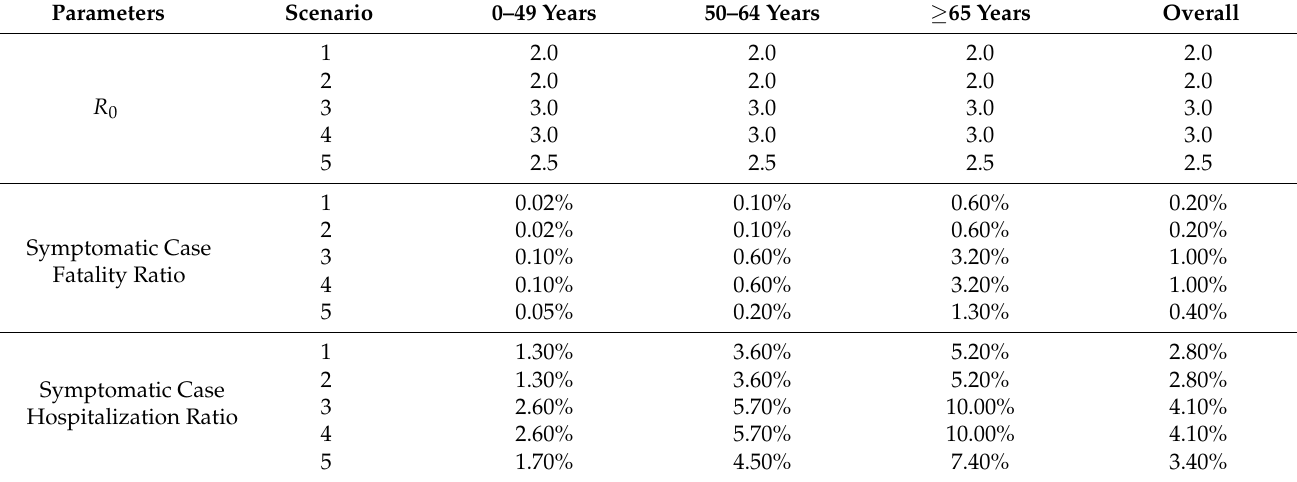
Table 3. Variable characteristic parameter values for COVID-19; sourse